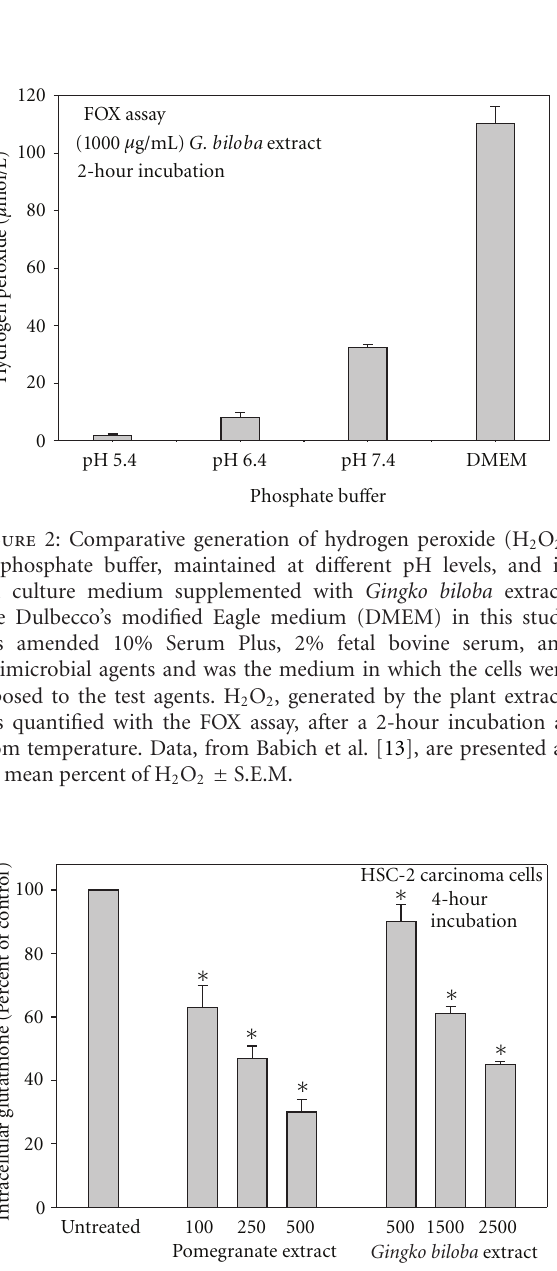
Figure 3: Decreases in intracellular reduced glutathione (GSH) following a 4-hour exposure of HSC-2 carcinoma cells in Dulbecco’s modified Eagle medium amended with pomegranate extract [14] and with Ginkgo biloba extract [13]. The data are expressed as the arithmetic mean ± S.E.M.; in unexposed cells, the basal level was approximately 32nmoles GSH/10 6